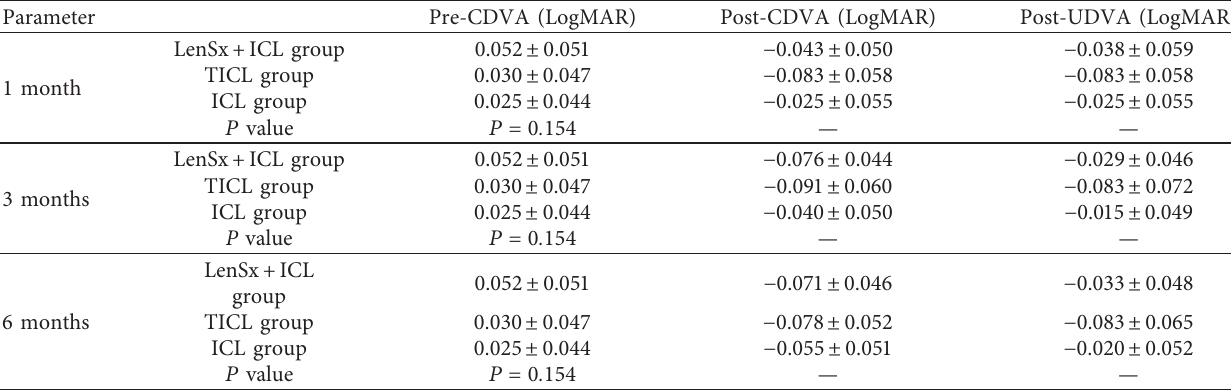
Table 2: The UDVA and CDVA before and after surgery in each group. Parameter Pre-CDVA (LogMAR) Post-CDVA (LogMAR) Post-UDVA (LogMAR)